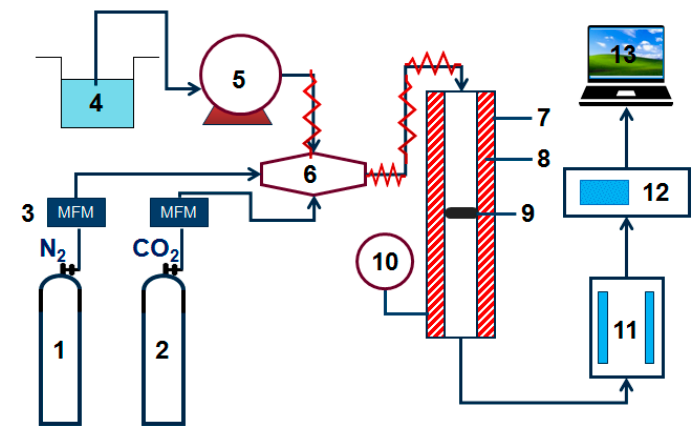
Figure 1. Fixed bed reaction device diagram.